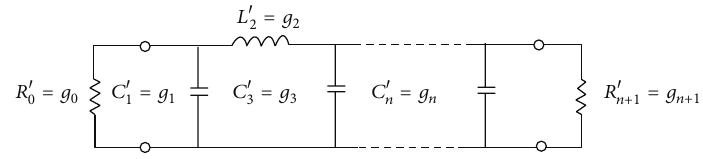
Figure 1: Circuit model and primary template of a low pass filter [1].